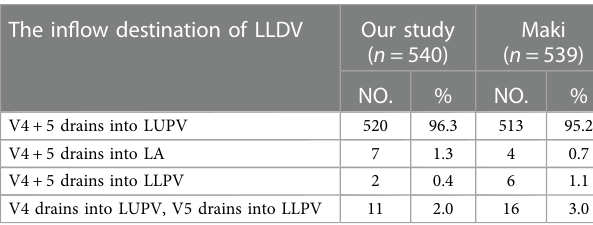
TABLE 2 Branching patterns of the left lingular division veins.